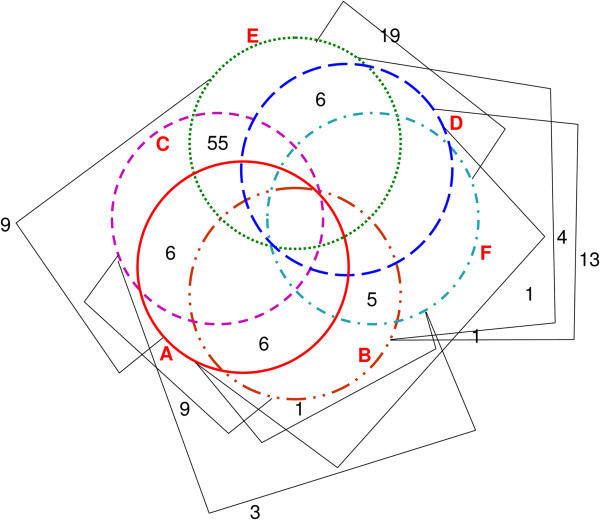
Overlapping genes up-regulated by 1,25(OH)2D3 10-100nM in cell lines. Venn diagram of 1,25(OH)2D3 up-regulated genes in breast cancer slices (A) cancer associated fibroblasts and normal adjacent fibroblasts (B) [40]; non-transformed prostate epithelial cell line (C) [44]; human coronary artery smooth muscle cells (D) [46]; SCC25 cells (floor of the mouth/base of the tongue squamous tumor, (E) [43] and lymphoblastoid cell lines (F) [45]. B, C, and D include non-transformed cells. Number of genes regulated in two cell lines appears on the diagram; number of genes regulated in more than two cell lines appears on the text.